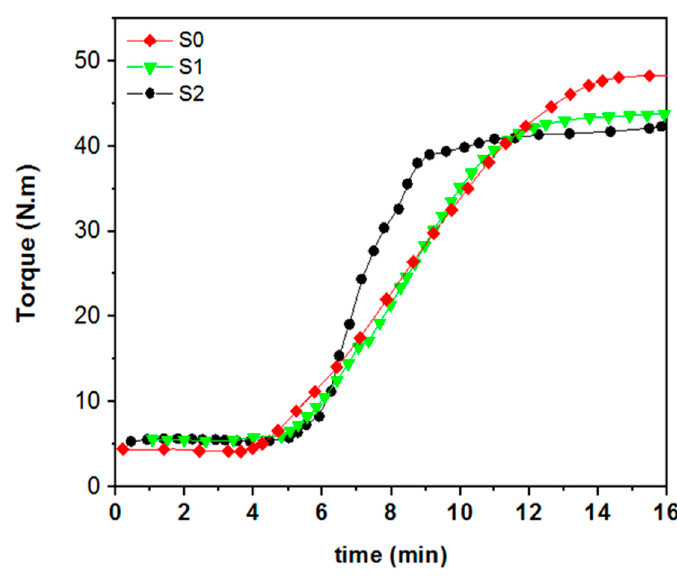
Figure 1. Rheometric curves of NR/CNT/GNS hybrid nanocomposite foams at 155 ◦ C. Table 2. Curing characteristics of NR/CNT/GNS hybrid nanocomposite foams at 155 °C .